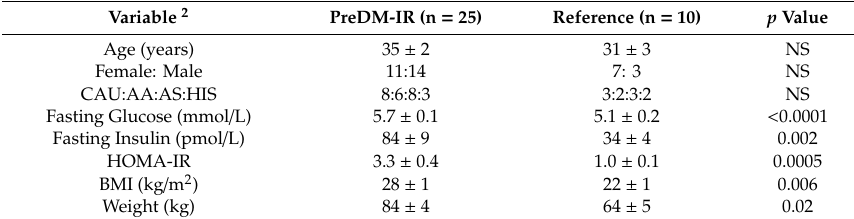
Table 1. Subject demographic characteristics at baseline 1